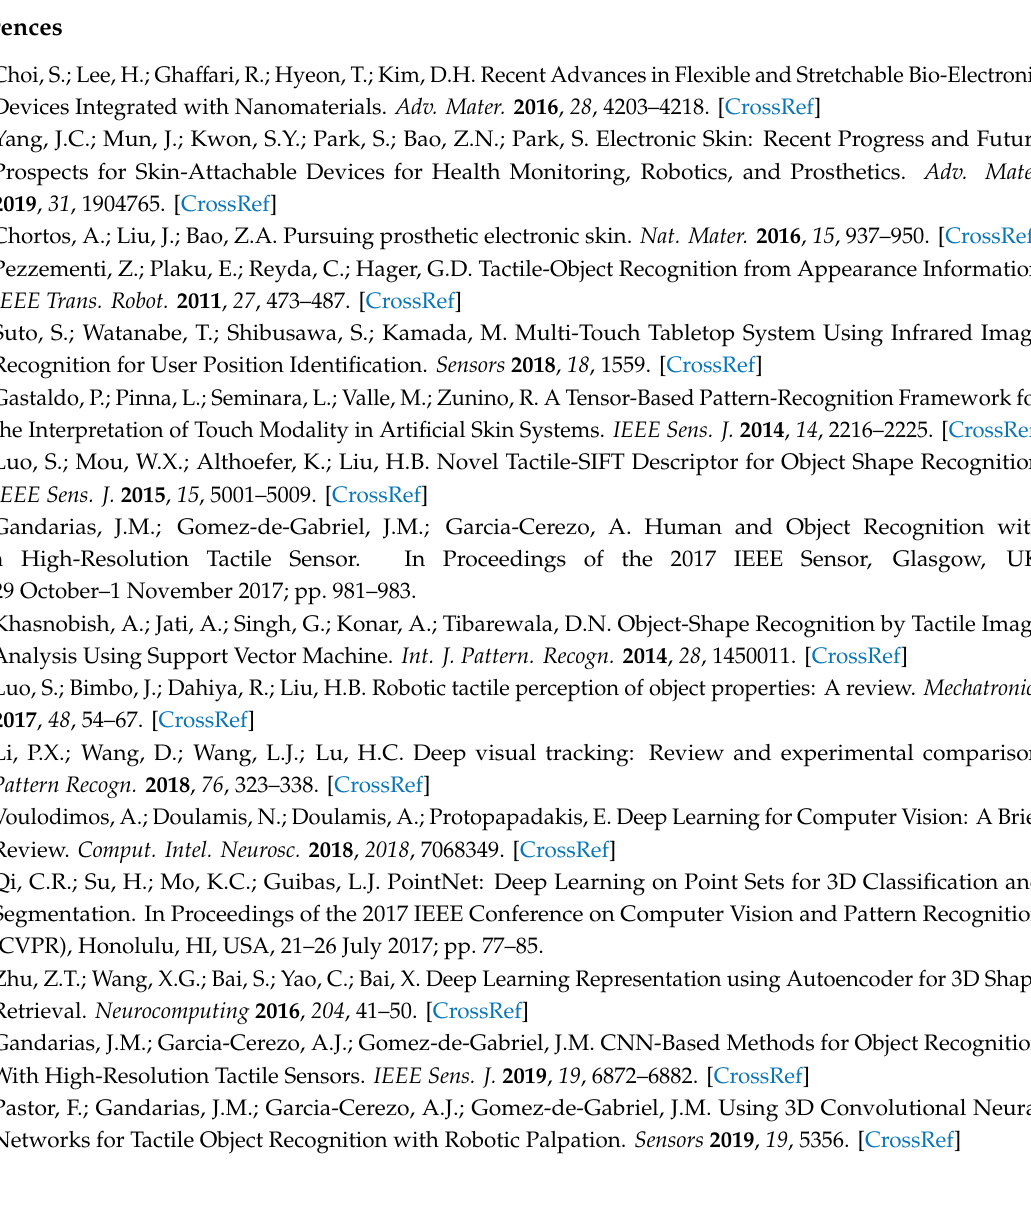
Figure S1: Examples of MNIST, Figure S2: Accuracy of BMF-CNN on MNIST, Table S1: Performance comparison on